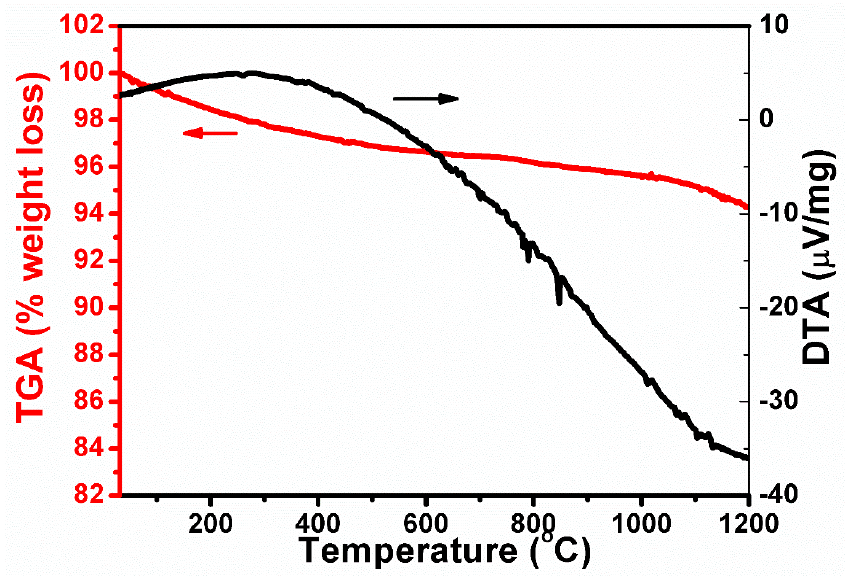
Figure 6. Results of thermal analysis (DTA and TGA) of the sample 2Si-N.